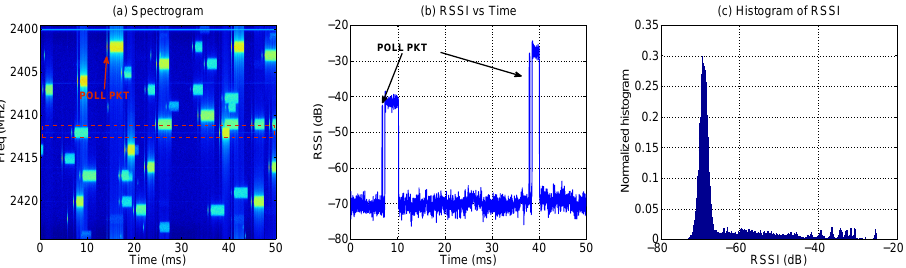
Figure 9. Characteristics of the Bluetooth signal: ( a ) the 25 MHz-wide spectrogram of the Bluetooth signal; the 1-MHz signals on the middle channel are extracted to obtain the RSSI, as shown in ( b ); ( c ) the normalized histogram of the narrowband